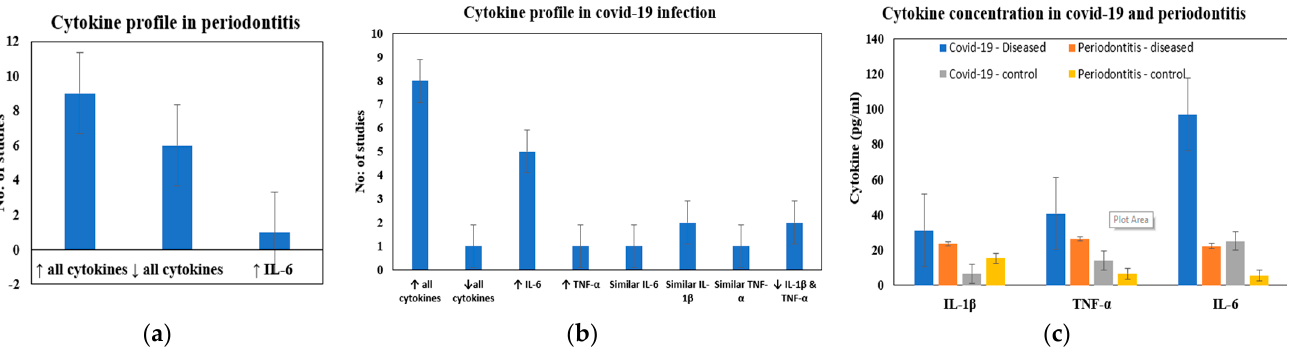
Figure 3. ( a ) Cytokine profile in periodontitis patients; ( b ) Cytokine profile in COVID-19 patients; ( c ) Comparison of cytokine levels between COVID-19 and periodontitis. (Arrows indicate increase or decrease in cytokine levels). Table 1. Data collected from included studies from the periodontitis search strategy.